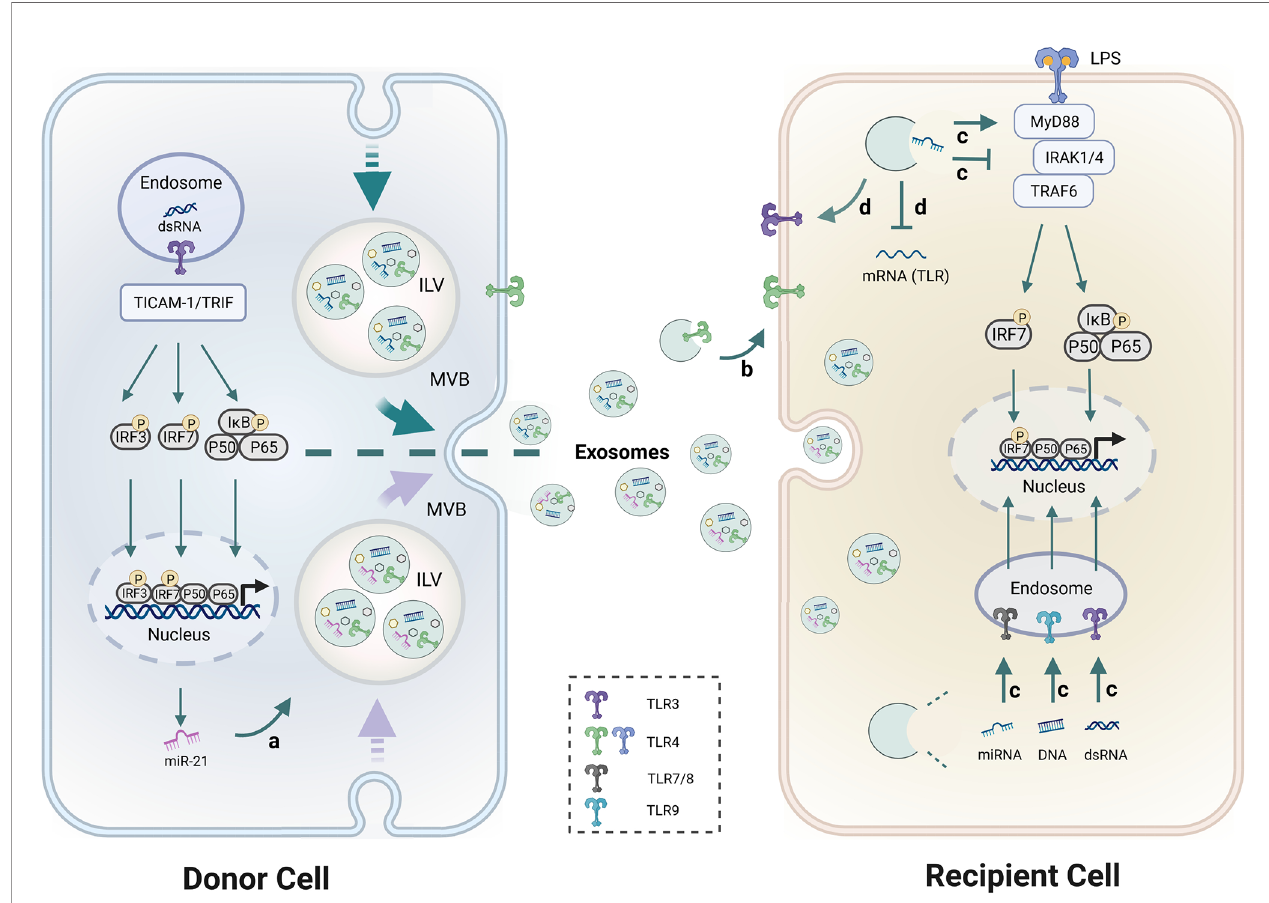
FIGURE 2 | Schematic diagram of the interaction between exosomes, miRNAs and TLRs. a. TLR3 senses dsRNA and utilizes the adaptor TRIF to activate IRF3 and NF- k B. Activation of TLR3 and its adaptor TICAM-1 increased miR-21 levels in exosomes. b. TLRs like TLR4 within exosomes can be transferred from donor cells to recipient cells. c. Exosome-encapsulated miRNAs, dsRNA and DNAs have the ability to regulate TLR7/8, TLR3, and TLR9 signaling pathways respectively, and induce immune activation and immunosuppression. d. Exosomal-miRNAs were found to suppress or up-regulate TLRs expression. MyD88 and TRIF are two major TIR domain-containing adaptors downstream of TLRs. IRFs and NF- k B are the common downstream transcriptional factors in TLRs pathways that regulate gene expression. Detailed descriptions are provided in the main